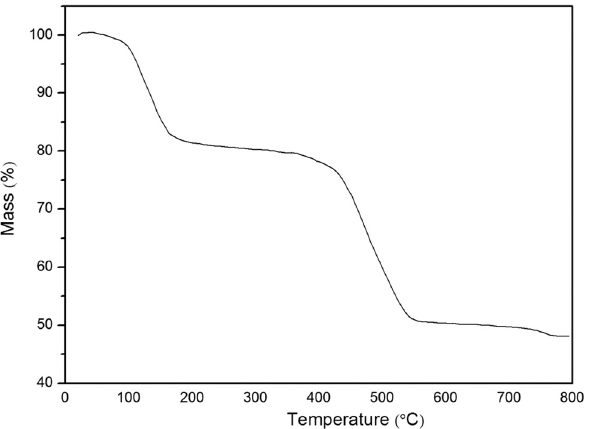
Figure 5: TG of Zn - MOFs.